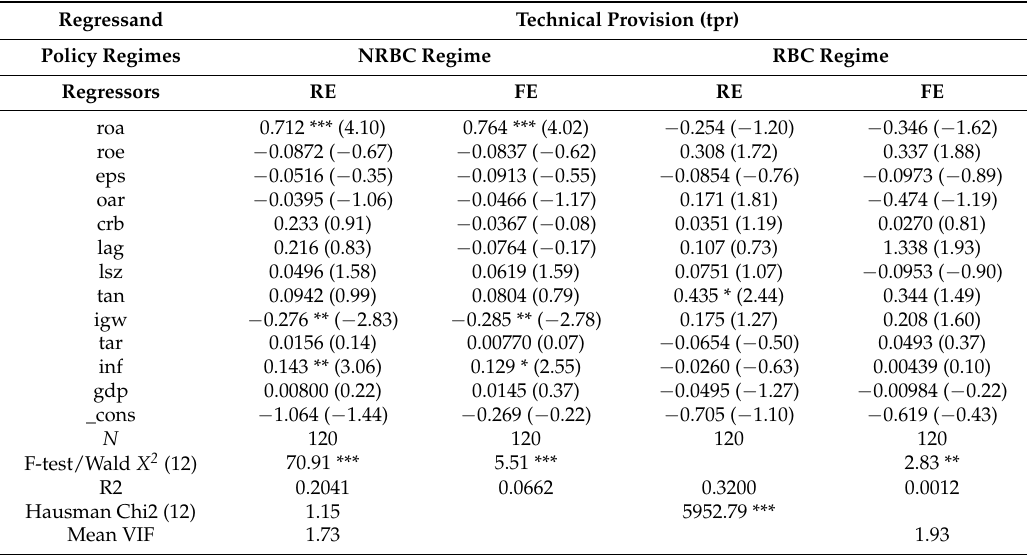
Table 5. Insurance performance regressions on capital structure for 1995–2002 and 2008–2015. Regressand Technical Provision